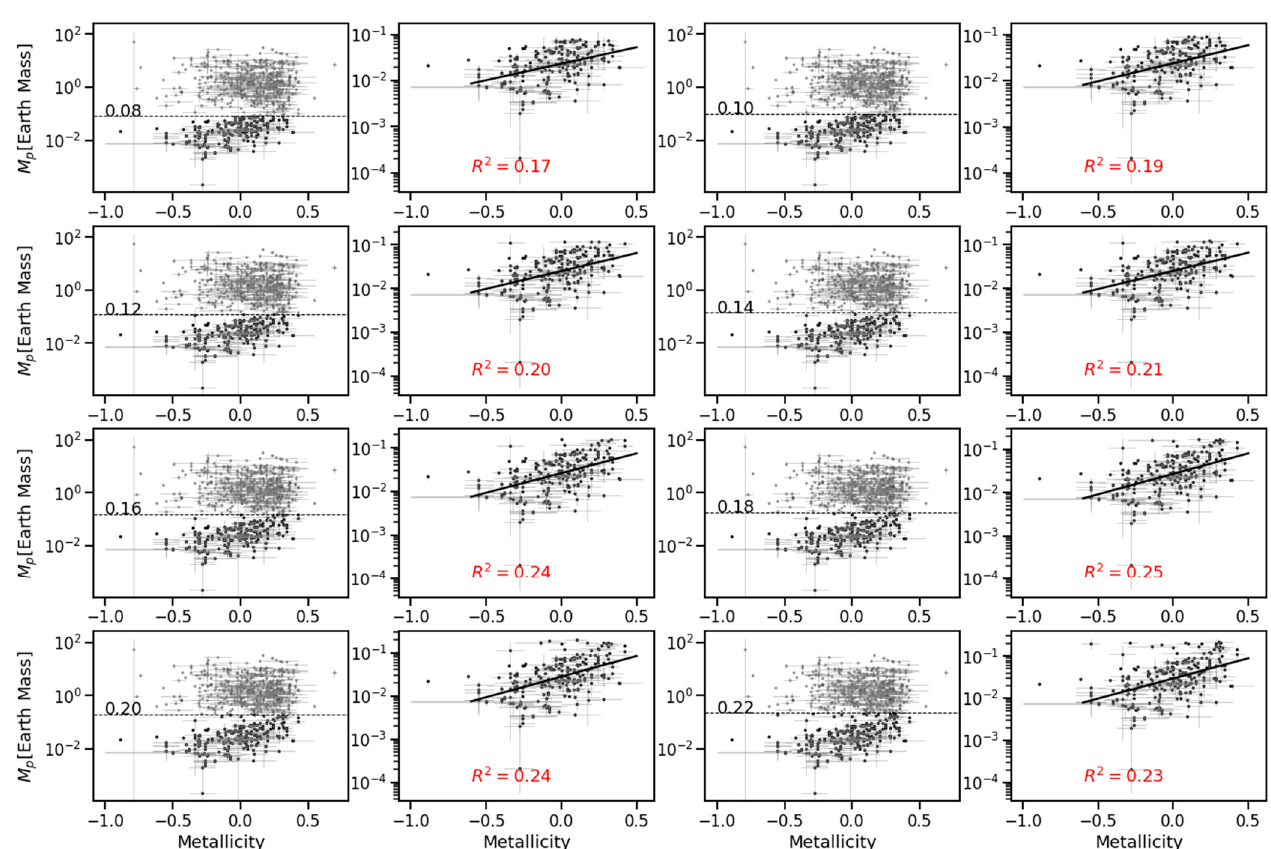
Figure A1. The first and third columns show scatter plots for planetary mass against the metallicity of planets satisfying our criterion (2) and (3). The gray dots represent the high-mass planets, of which the masses are above different cutoffs as shown by the gray horizontal lines, while the black dots represent the low-mass planets, of which the masses are lower than the cutoffs. The linear regressions for those low-mass planets are shown to the left and the fitting scores (R 2 ) are shown on the figure.